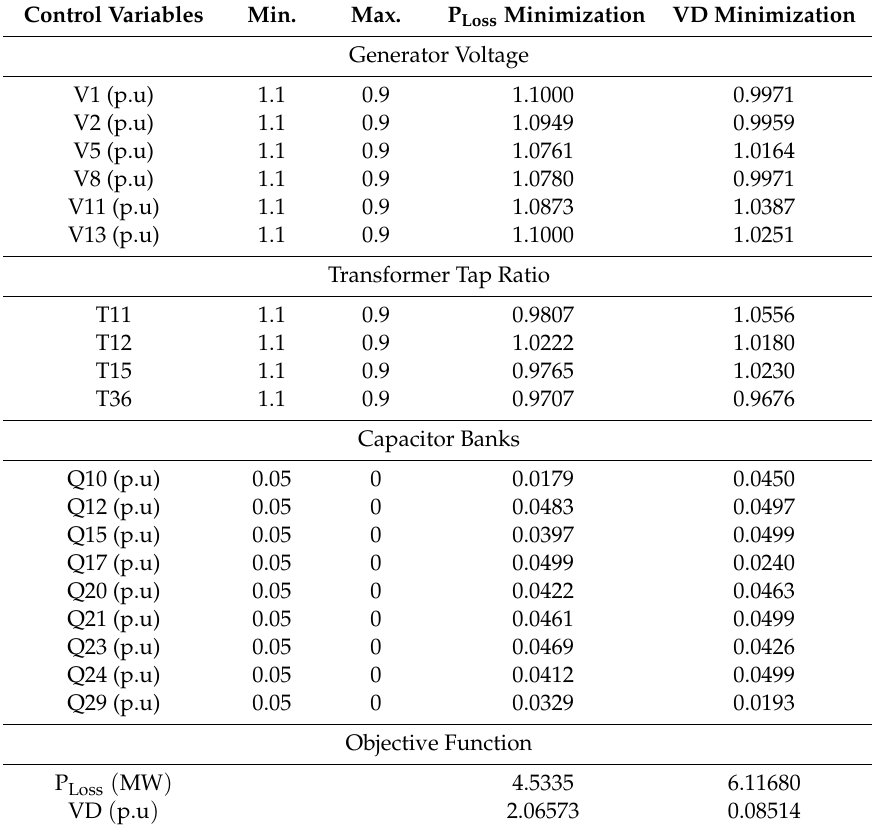
Table 2. The optimal control variables for P Loss and voltage deviations ( VD )